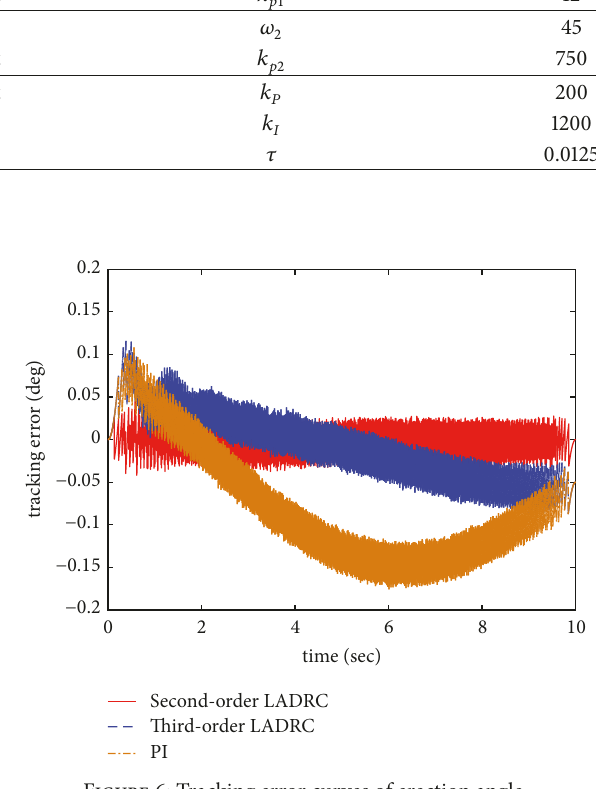
Figure 6: Tracking error curves of erection